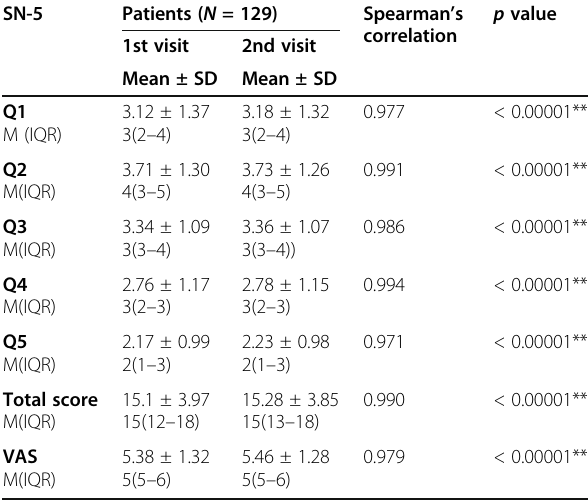
Table 1 Age and sex of the studied groups Patients ( n = 129)